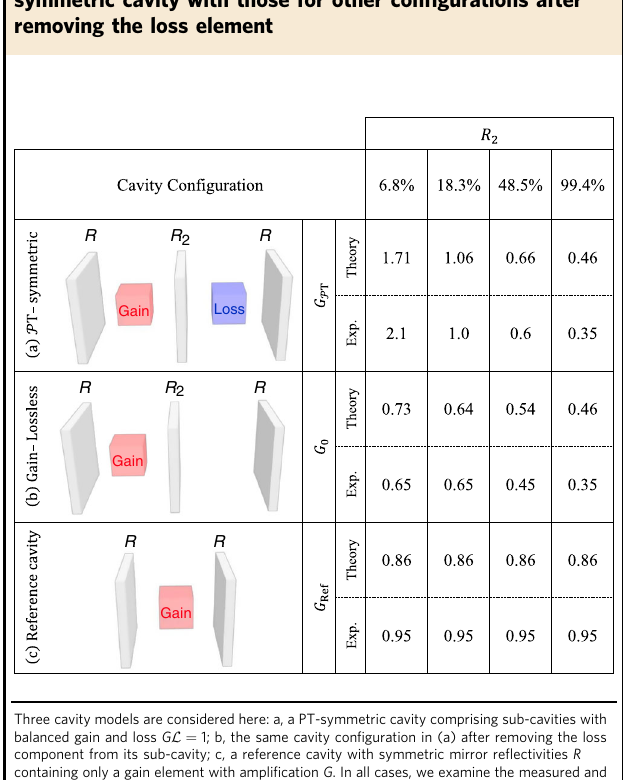
Table 1 Comparison of the lasing threshold of a PT- symmetric cavity with those for other con fi gurations after